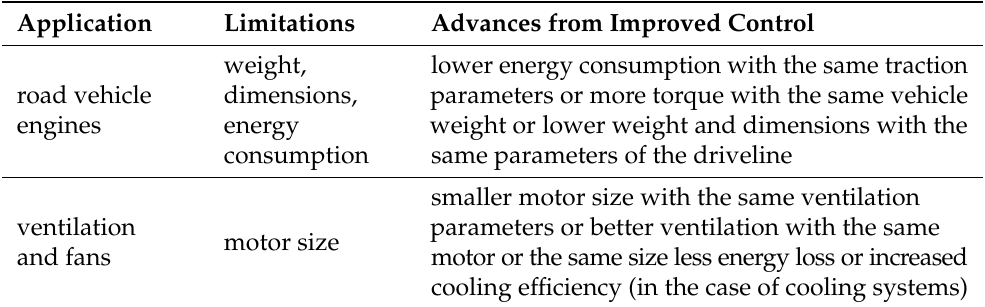
Table 1. Selected BLDC motor applications and benefits of improved control for reduced energy losses in the form of heat in the